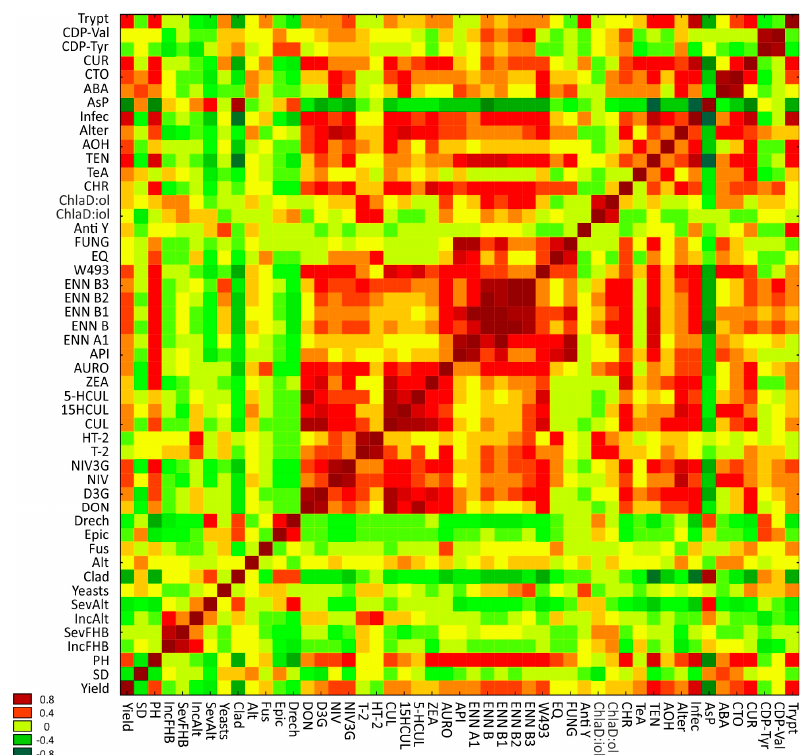
Figure 5. The correlation plot for yield, spike health, spike density, plant height, grain colonization by fungi, and the content of fungal metabolites presented in the form of heat map. SD—spike den-